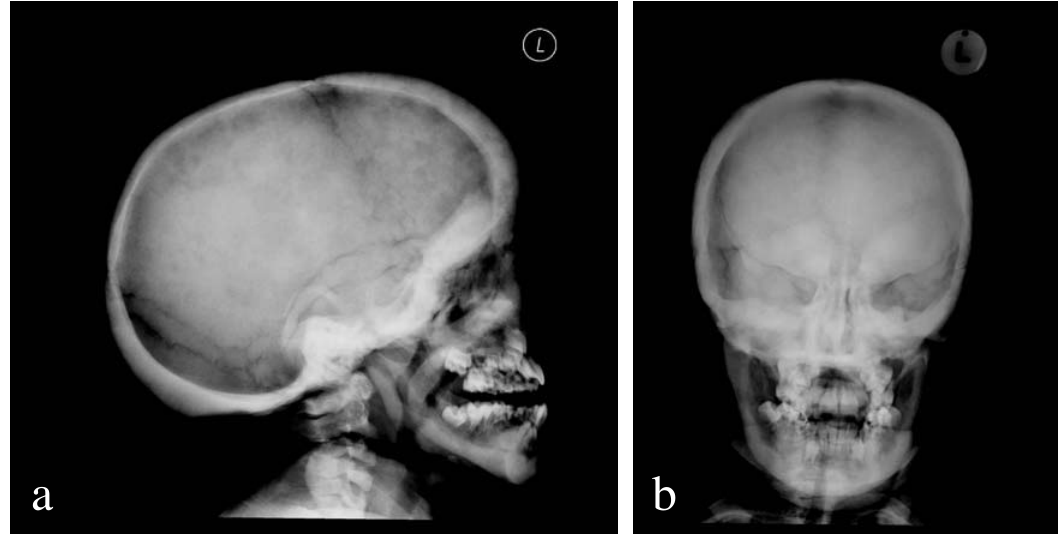
Figs 5a and b. The skull radiographs demonstrate sclerosis of the skull base and temporal bone, particularly of the external auditory canal.